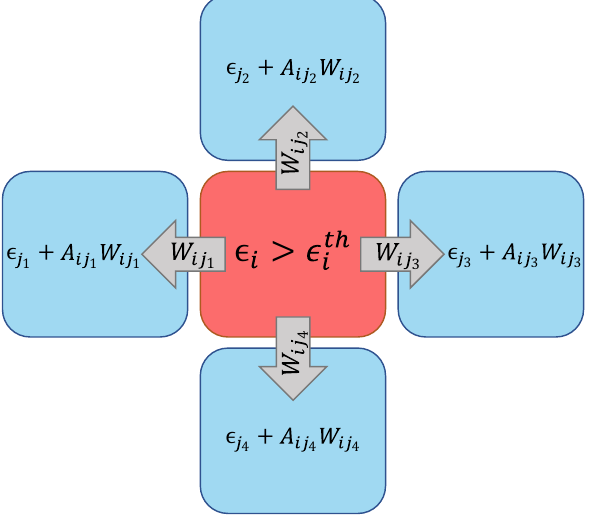
Figure 4. A schematic 2D set-up of the sandpile model. The rad site, i , is unstable since ǫ th i > ǫ i and sends W ij stress to any neighboring sites, but the neighboring sites get A ij W ij